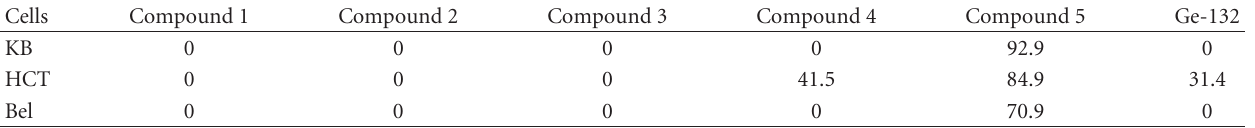
Table 1: Inhibition yields (%) of the five compounds and Ge-132 at the concentration of 50 μ g/mL.